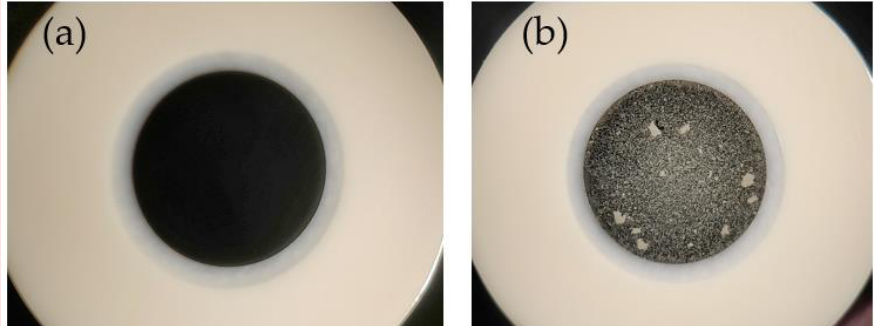
Figure 7. Magnified and externally illuminated working electrode disk (GC) surface before ( a ); and after ( b ) the drop casting of N-G/MOF